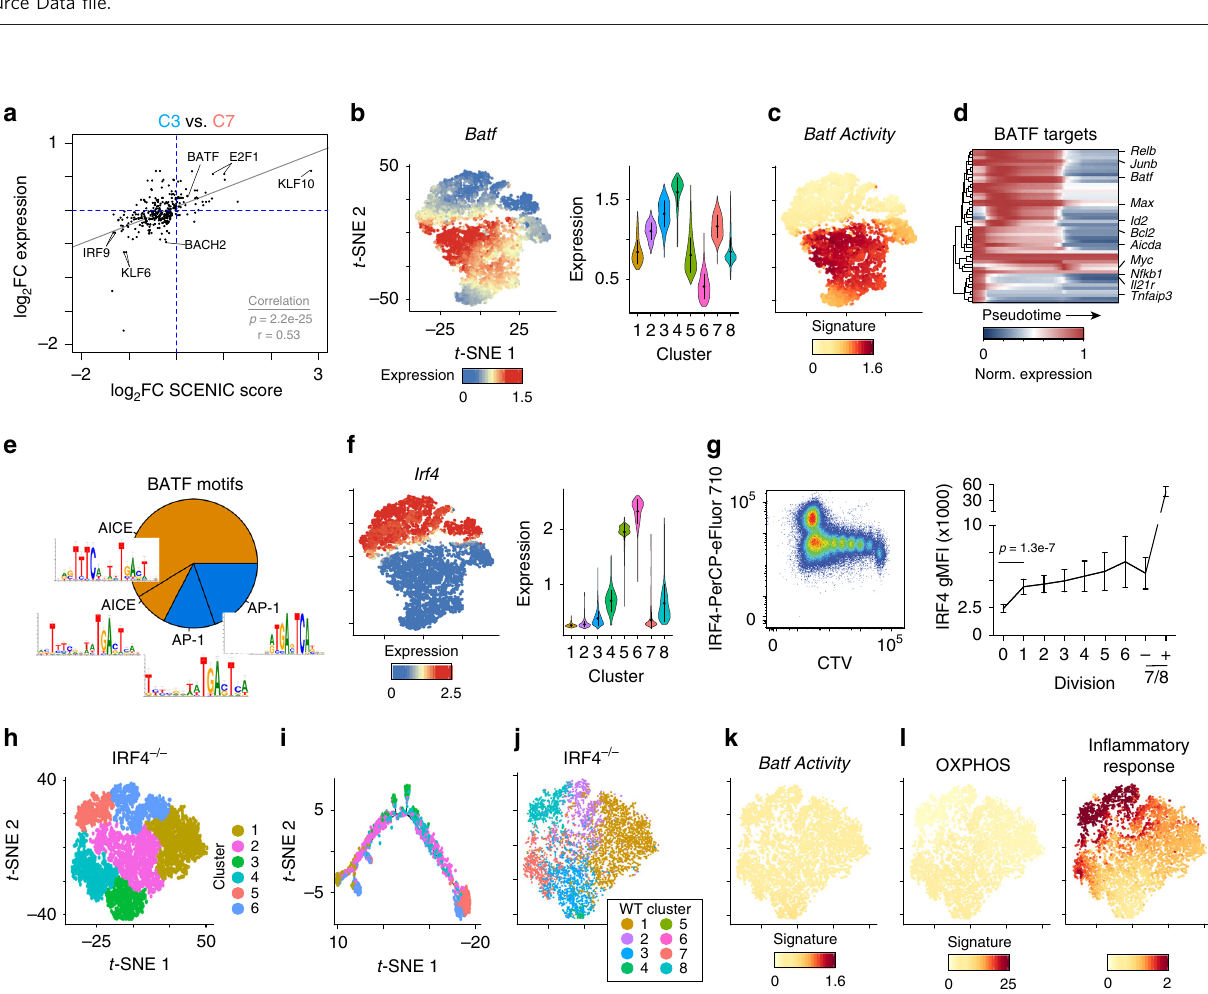
Fig. 5 Pseudotime identi fi es divergent activated B-cell differentiation trajectories. a t -SNE plot of pseudotime ordered cells from Fig. 4a showing the location of cells from each cluster. Open circles denote pseudotime branch points. b Schematic showing the pseudotime order of cells from ( a ) (left) and from the t -SNE plot from Fig. 4a (right). c Pseudotime t -SNE plot from ( a ) (left) or from scRNA-seq data on adoptively transferred cells responding to LPS (middle) or NP-Ficoll (right) in WT hosts showing cells annotated based on division sorted LPS-responding B cells from Barwick et al. 16 (see Fig. 4e and Supplementary Fig. 1). Circles denote pseudotime branch points. d GSEA of the indicated datasets comparing the transcriptional pro fi le between cells in clusters 3 and 7. e t -SNE plot showing mean MAGIC expression levels for all Leading Edge genes from the GSEA gene set in ( d ). f Violin plots showing MAGIC expression levels for cells in clusters 3 and 7 for the indicated genes. Genes were chosen from the adjacent GSEA gene set from ( d ). Within each violin plot, the dots represent mean MAGIC expression levels and lines represent fi rst and third quartile ranges. g GSEA of the indicated datasets comparing the transcriptional pro fi le of cells in clusters 5 and 6. h t -SNE plot showing mean MAGIC expression levels for all Leading Edge genes from the adjacent GSEA gene set in ( g ). The ER chaperones, co-chaperones, and folding enzymes gene set were described previously 34 . i Violin plots of select genes representative of gene sets in ( g ). WT LPS and WT NP-Ficoll scRNA-seq data in ( c ) represent combined cells from two independent mice. Signi fi cance for GSEA was calculated by permutation testing with P < 0.001 indicating the gene set was enriched over all 1000 permutations. Source data are provided as a Source Data fi le.